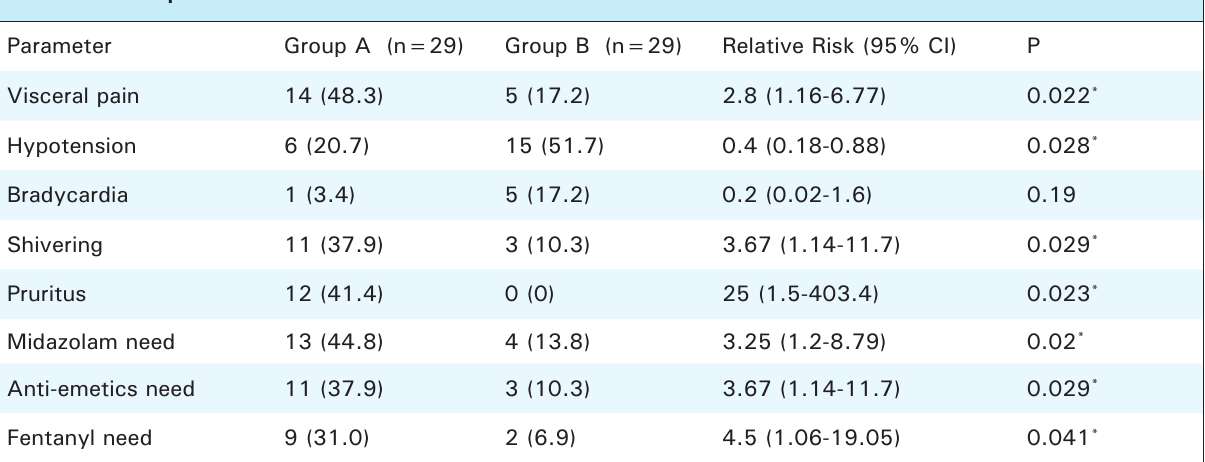
Table 2. Intra-operative events and medications